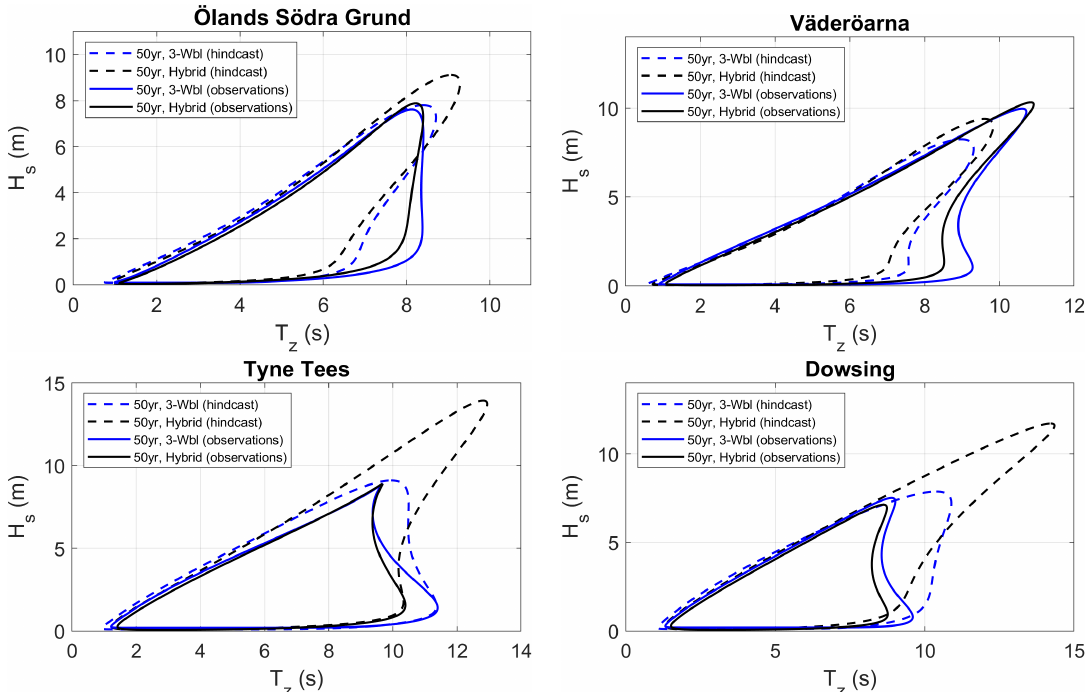
Figure 12. Comparing 50-year environmental contours for the observations (solid lines) and the model data (dashed lines). Two methods are shown: (1) I-FORM with 3-parameter Weibull fit for H s , with β inflated using α 2 (2) I-FORM with a hybrid fit for H s , without inflation (black